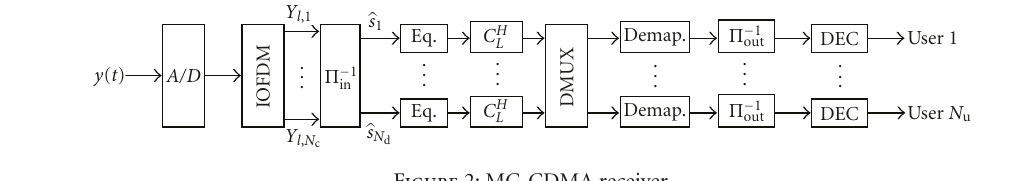
Figure 2: MC-CDMA receiver.